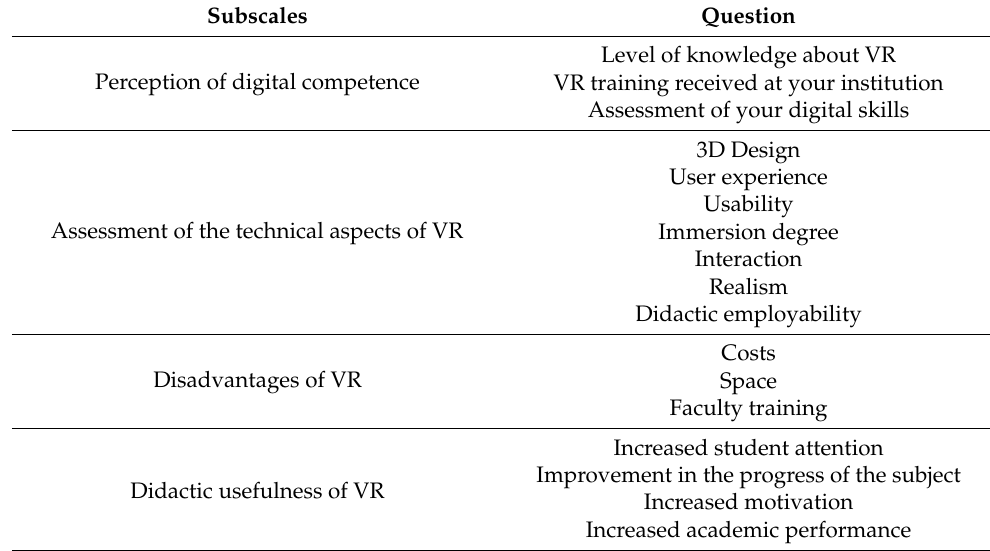
Table 2. Subscales and questions of the